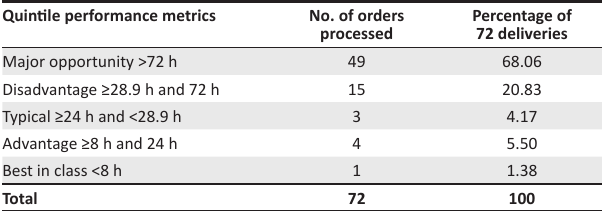
TABLE 7: Total order cycle